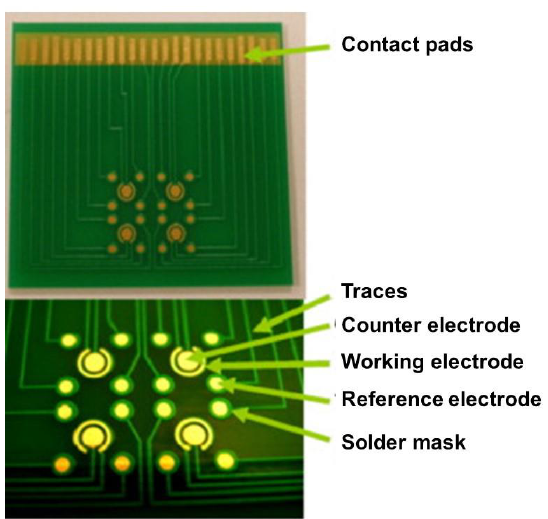
Figure 4. Photograph of the array chip fabricated using screen-printed Au ink on a PCB substrate. The diameter of the working and counter electrodes was 1 and 2 mm, respectively. The diameter of the outer and inner ring of the reference electrode was 4 and 3 mm. Reproduced with permission from [18], Copyright 2013 Elsevier.